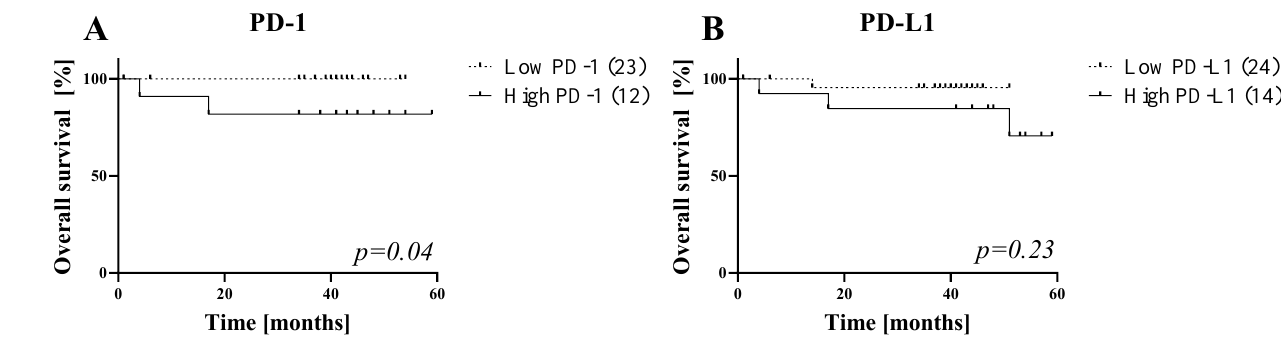
Figure 6. Overall survival of HNC patients depends on sEV PD-1 and PD-L1 abundance. ( A ) Higher sEV PD-1 and ( B ) PD-L1 levels before therapy indicate worse survival rates in Kaplan–Meier analysis. Log-rank test revealed a significantly worse prognosis for patients with elevated PD-1 values on sEVs (lower right corner, p = 0.04).